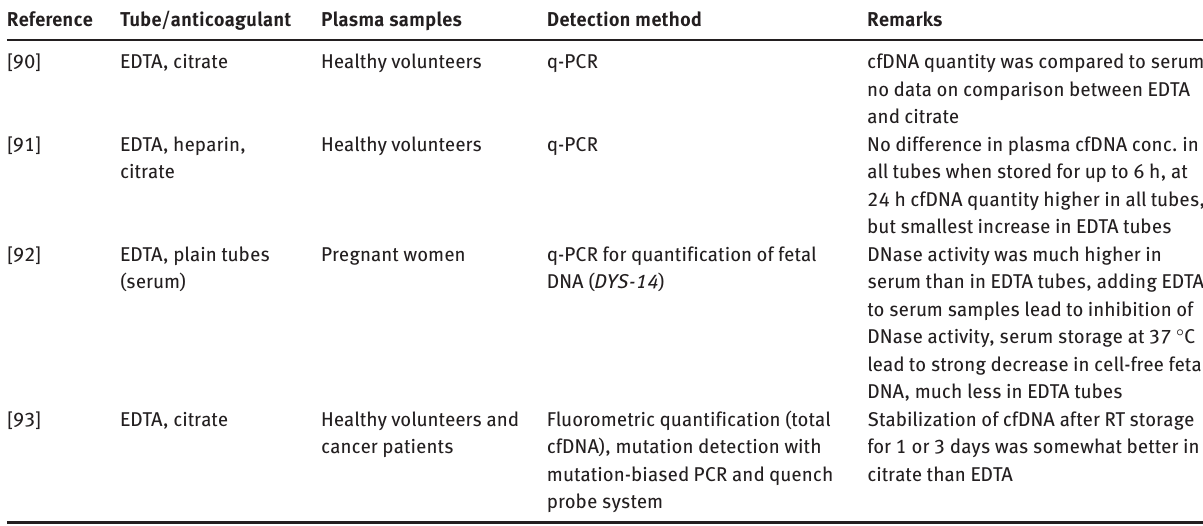
Table 3: Comparison of different